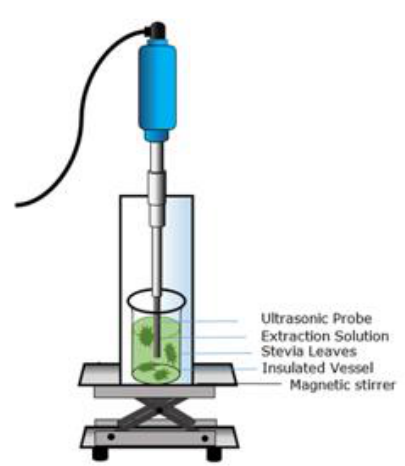
Figure 3. Ultrasound-assisted extraction system: without circulating water-bath.